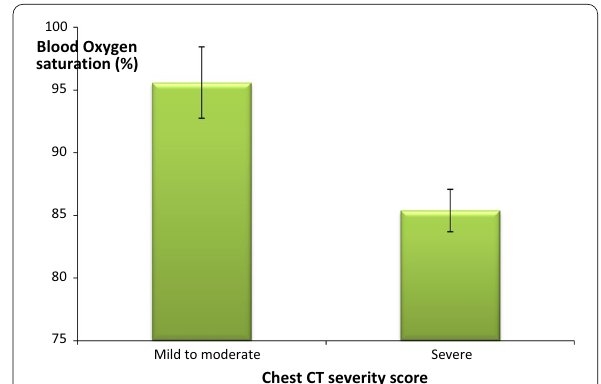
Fig. 4 Difference in blood oxygen saturation in relation to grading of chest CT severity